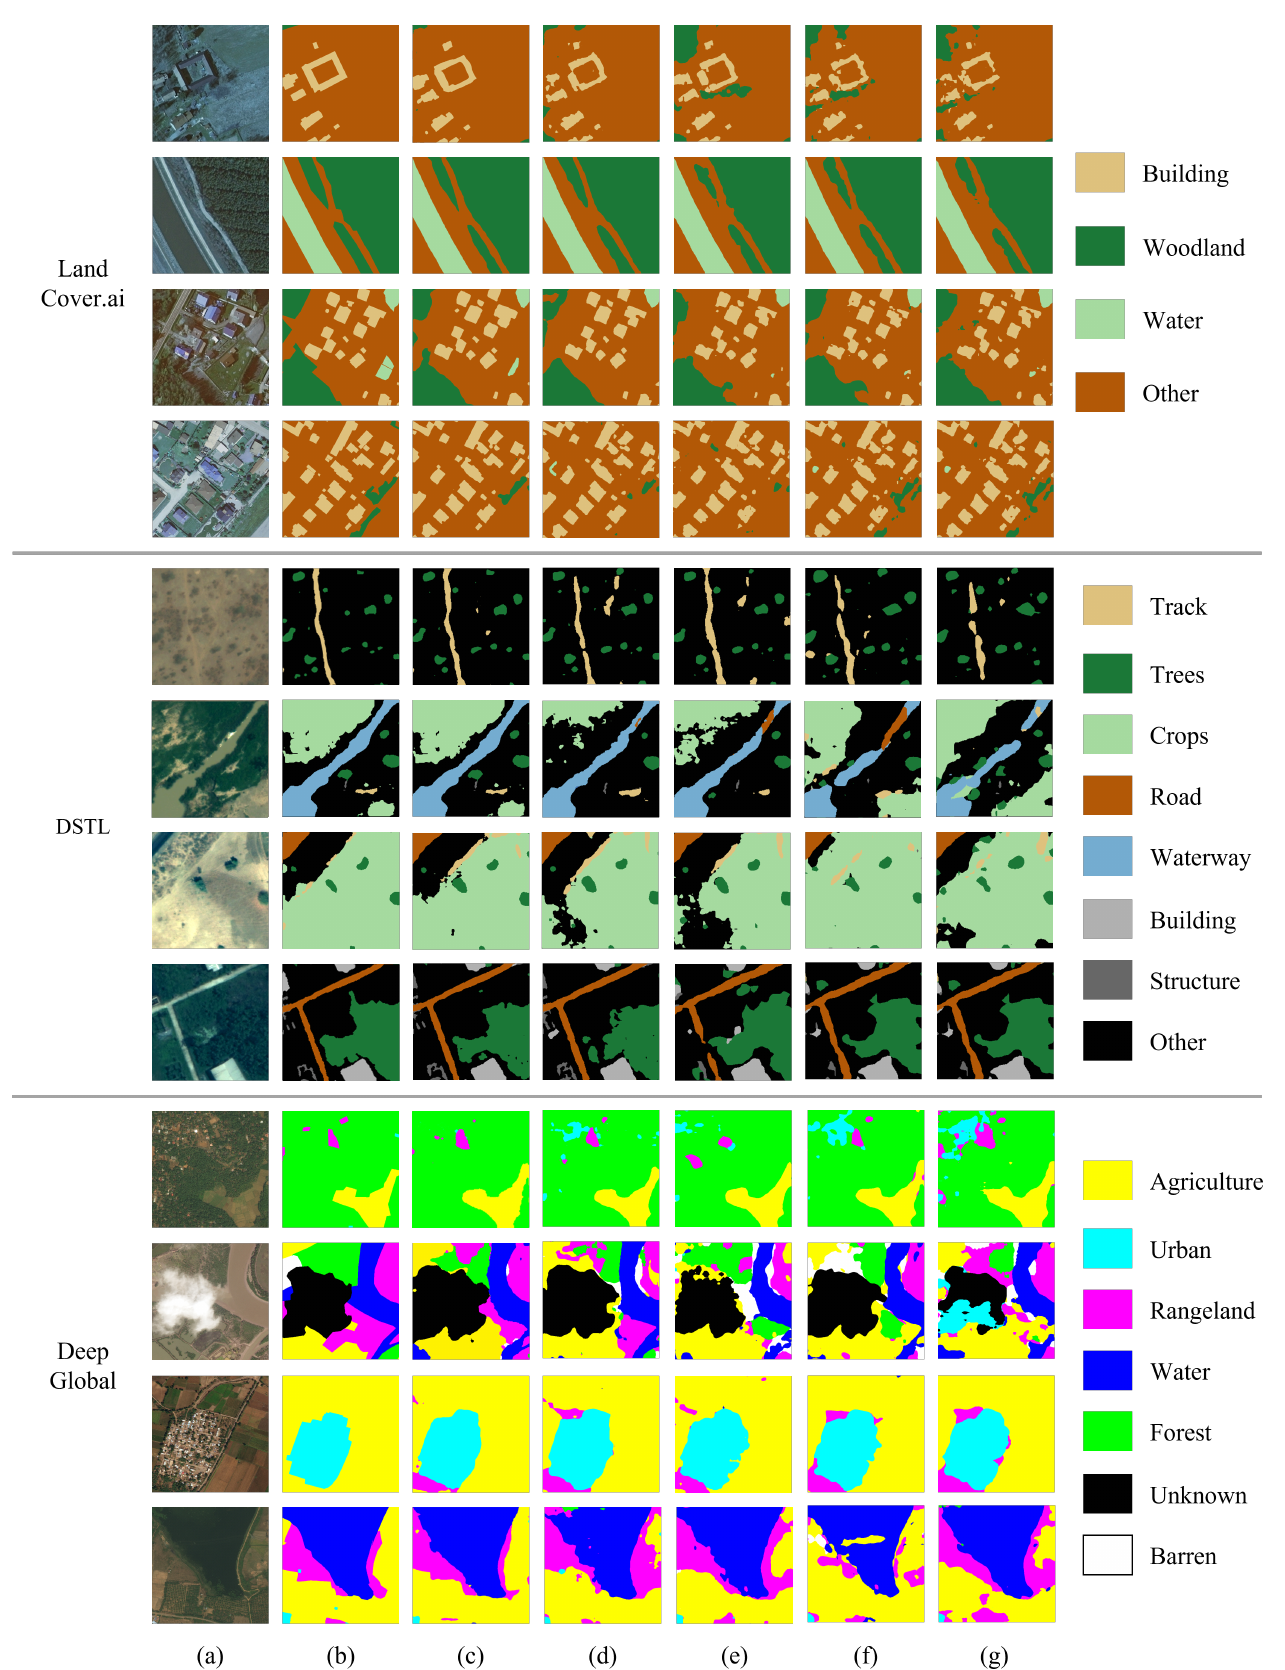
Figure 5. Comparison of different ablation models segmentation results on the three datasets: ( a ) Raw image, ( b ) Ground truth, ( c ) Whole, ( d ) PPD(Pyramid)+RFB+AA, ( e ) PPD(Pyramid)+RFB, ( f ) PPD(Pyramid), ( g )